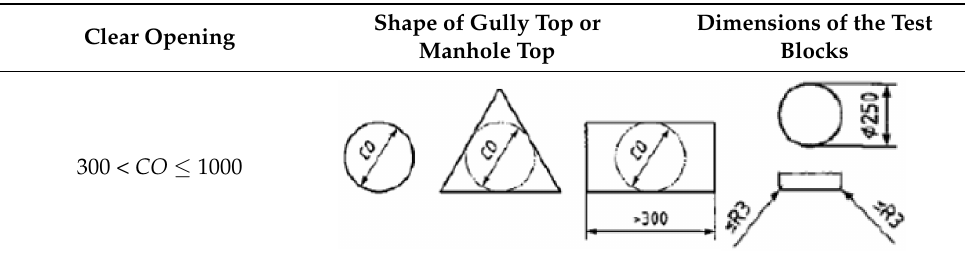
Table 1. Dimensions and shape of the manhole top according to EN 124-1.